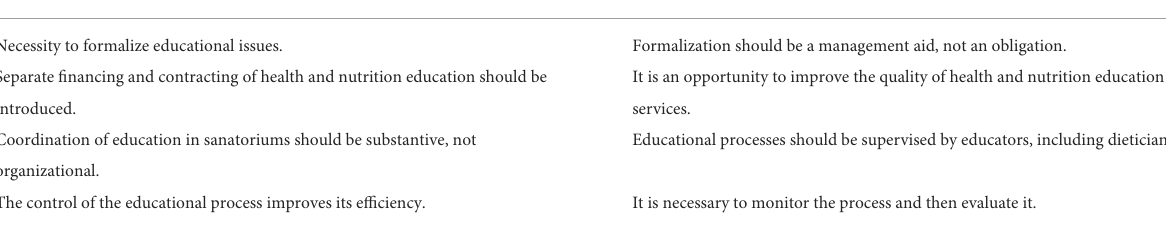
TABLE 2 Opinions and observations of experts in the field of legal-organizational aspects. Opinions and observations of